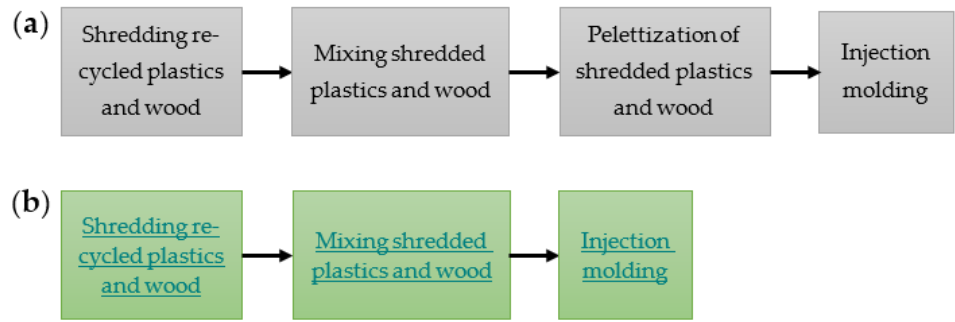
Figure 1. Schematic of wood – plastic composite production through ( a ) traditional method and ( b ) the method studied in this research.